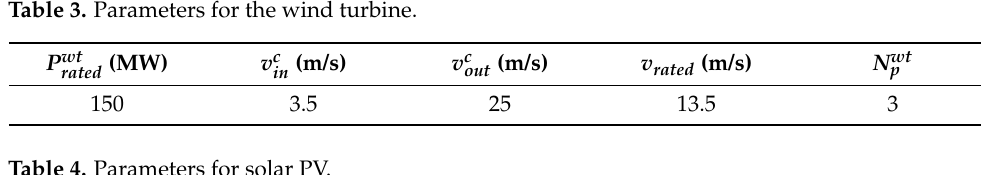
Table 4. Parameters for solar PV.